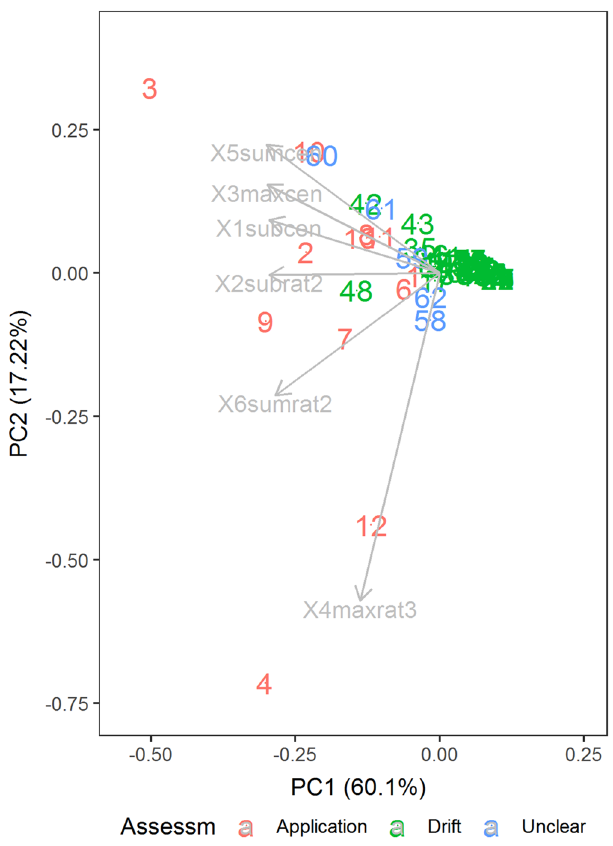
Figure 6. Principal Component Analysis (PCA) biplot of 67 farm samples for four variables used for the discriminant analysis (3maxcen, 2subrat2, 6sumrat2, 4maxrat3). The samples are coloured by the initial classification. The “drift” farms are clustered around (0, 0) while “application” farms are spread on left of the plot, and the "unclear" cases are distributed